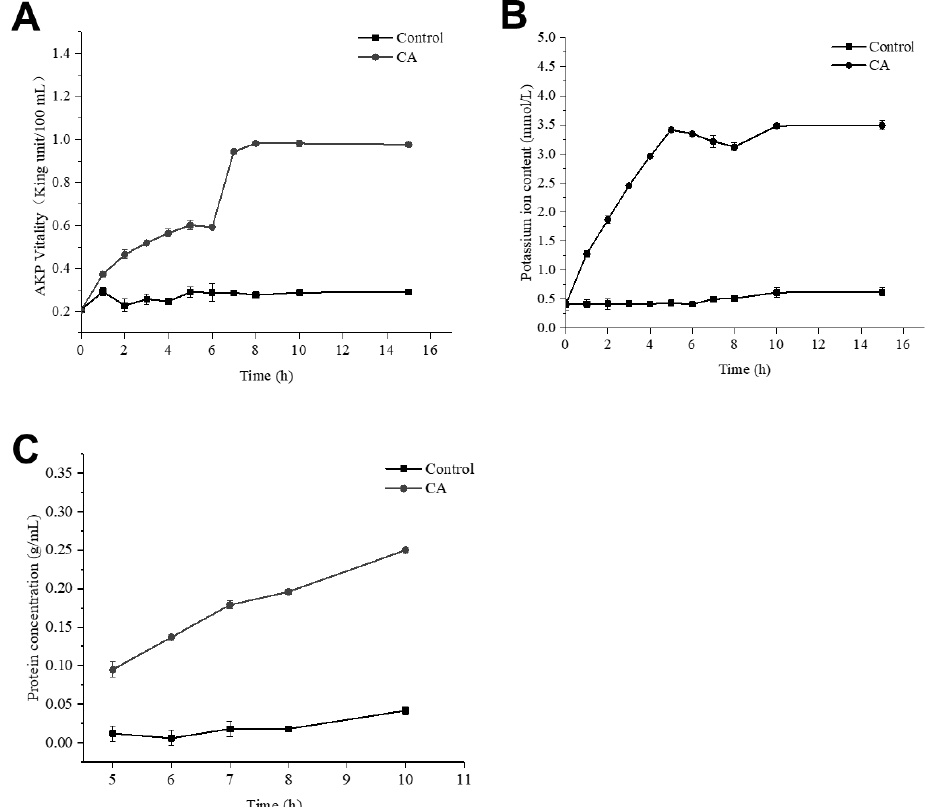
Figure 7. The changes in AKP concentration ( A ), K + concentration ( B ) and protein concentration ( C ) for S. aureus treated with CA.